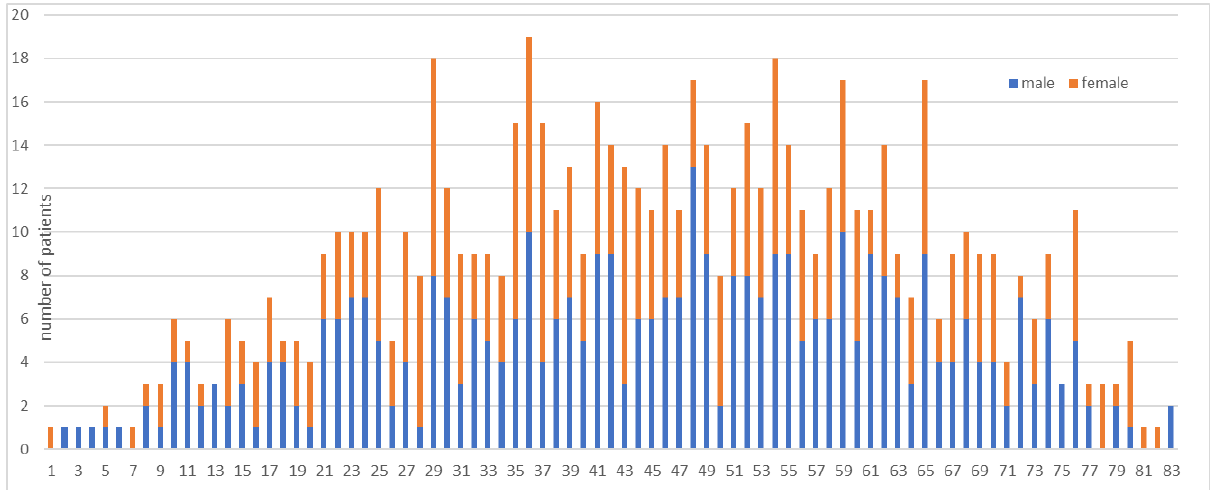
Figure 2. Age and gender distribution in the subject group.